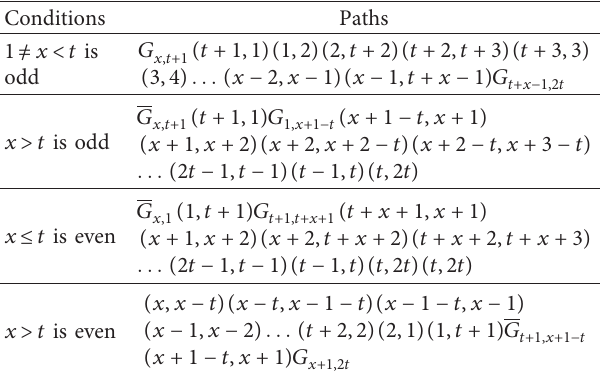
Figure 2: Hamiltonian path from 1 to 2 in T , when t is even. (a) n ≡ 2(mod ( t − 1)). (b) n ≡ (1+ i )(mod ( t − 1)); i ∈ {3, 5, .. . , t − 1}. (c) n ≡ (2+ i )(mod ( t − 1)) ≥ 2 t +1; i ∈ {1, 3, ... , t − 3}. Table 1: Hamiltonian paths from x to 2 t in 〈 T 〉 1 ,t when t is even. 2 t Conditions